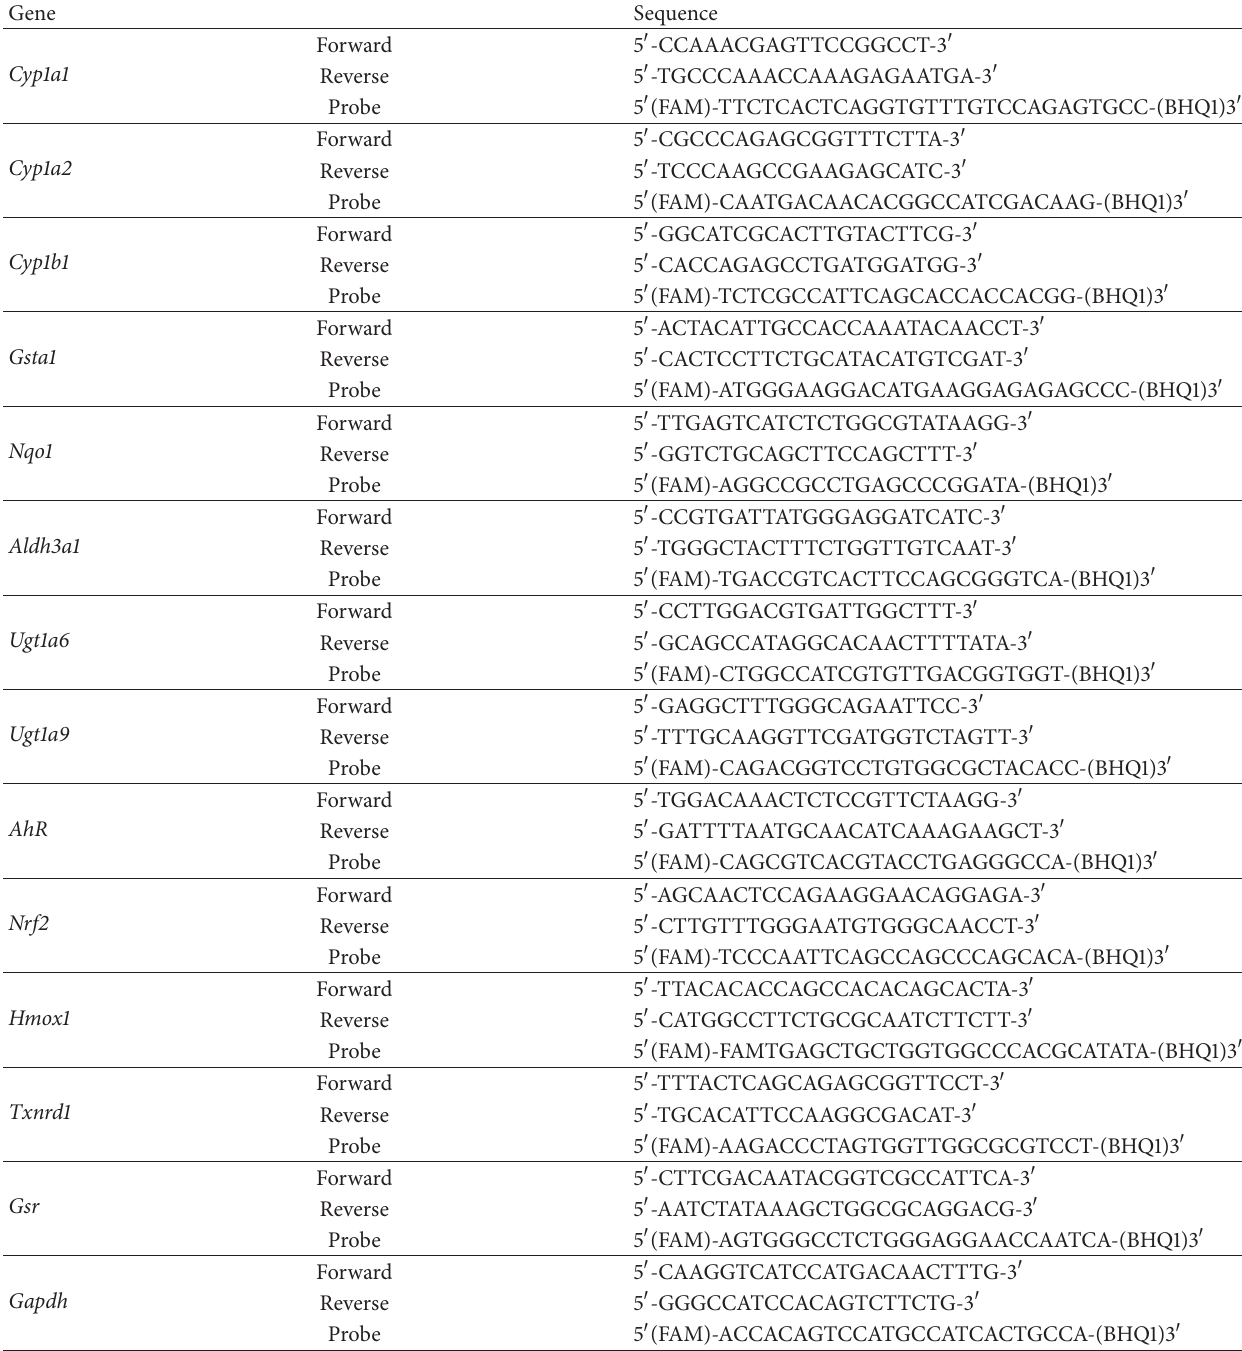
Table 1: Primer sequences for analysis of gene